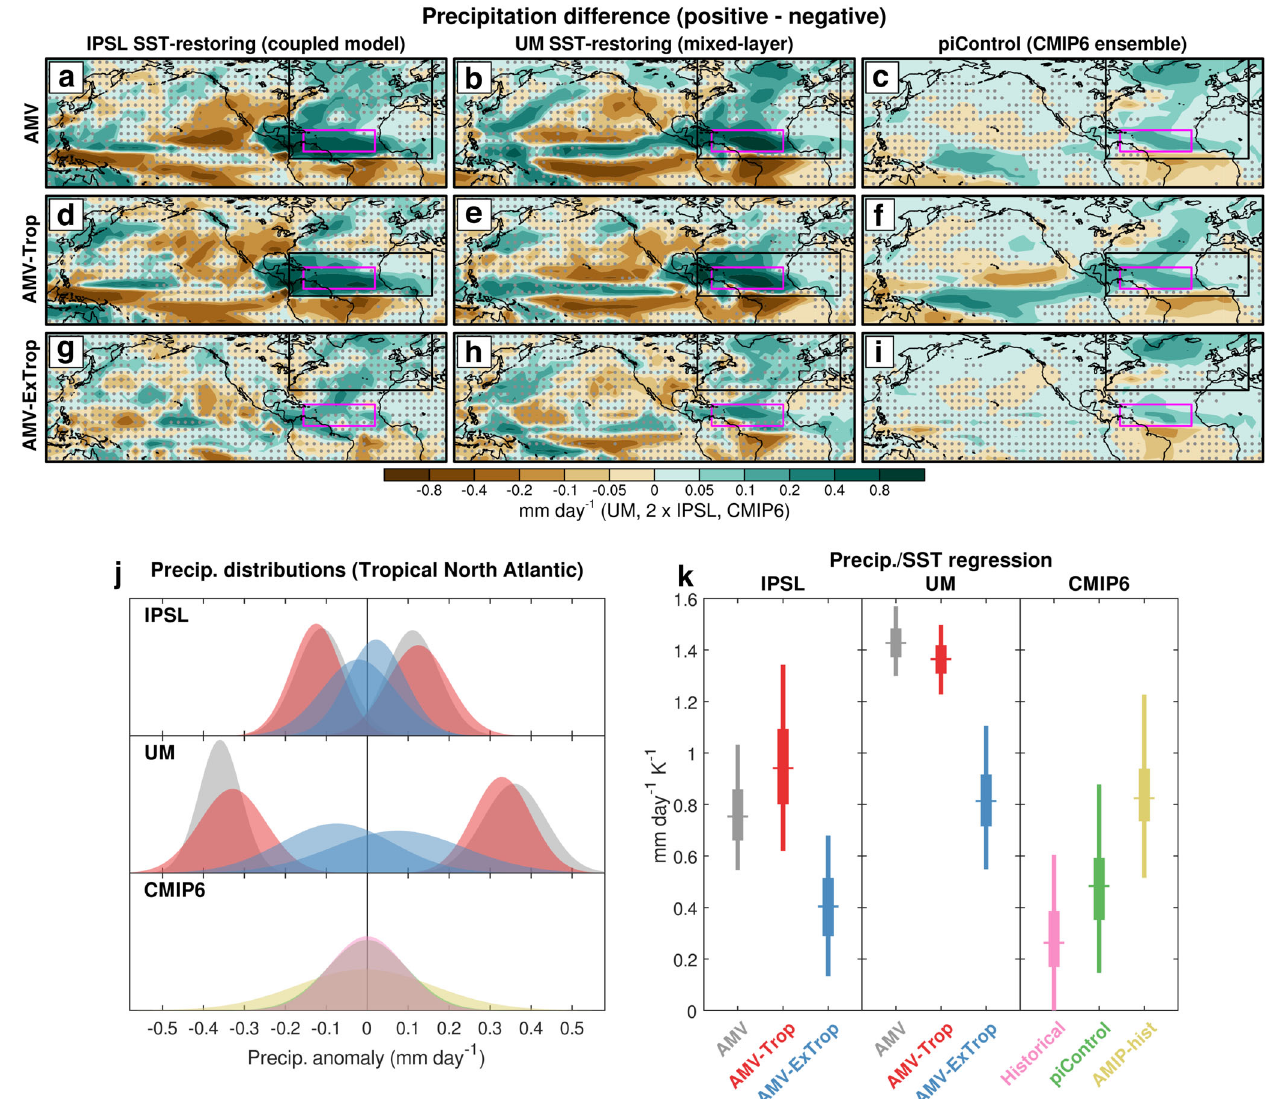
Fig. 3 Relationships between precipitation and the AMV. a – i Precipitation difference between SST + and SST- 10-year periods for the AMV, AMV-Trop and AMV-ExTrop regions (indicated by the black boxes). These are shown for the SST-restoring experiments for the IPSL and UM models; for the free-running coupled PiControl simulations the SST + and SST- decades are decades in which the SST in the region is above/ below one standard deviation from the mean. Hatching indicates where the differences are signi fi cant at the 95% level, based on a Monte Carlo resampling performed 10000 times (see Methods). j Gaussian distributions of the decadal tropical North Atlantic precipitation anomalies in the different ensembles (averaged over the regions shown by the magenta boxes in panels ( a – i )). k Regression of decadal precipitation anomalies onto decadal SST anomalies for the subtropical North Atlantic region. The regressions were calculated for all unique 140-year periods in the historical and piControl simulations and the box, centre-line and whiskers show the 5th-25th-50th-75th-95th percentiles of these distributions. For the SST-restoring experiments 10,000 random 140-year periods (i.e. 14 decades) were sampled and constructed from the ensemble members to calculate the regression; the box and whiskers show the distribution across these random samples for each